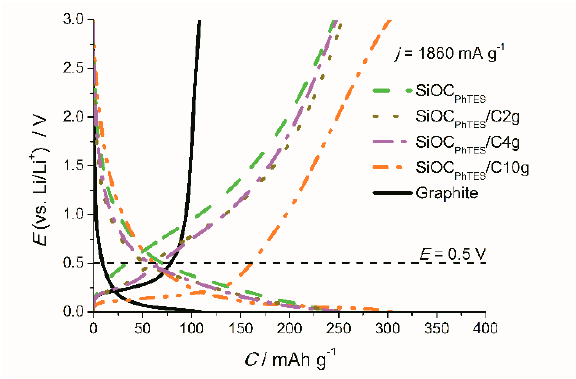
Figure 10. Galvanostatic charge–discharge curves of the investigated materials recorded at 1860 mA Figure10. Galvanostaticcharge–dischargecurvesoftheinvestigatedmaterialsrecordedat1860 mA g − 1 . g -1 .